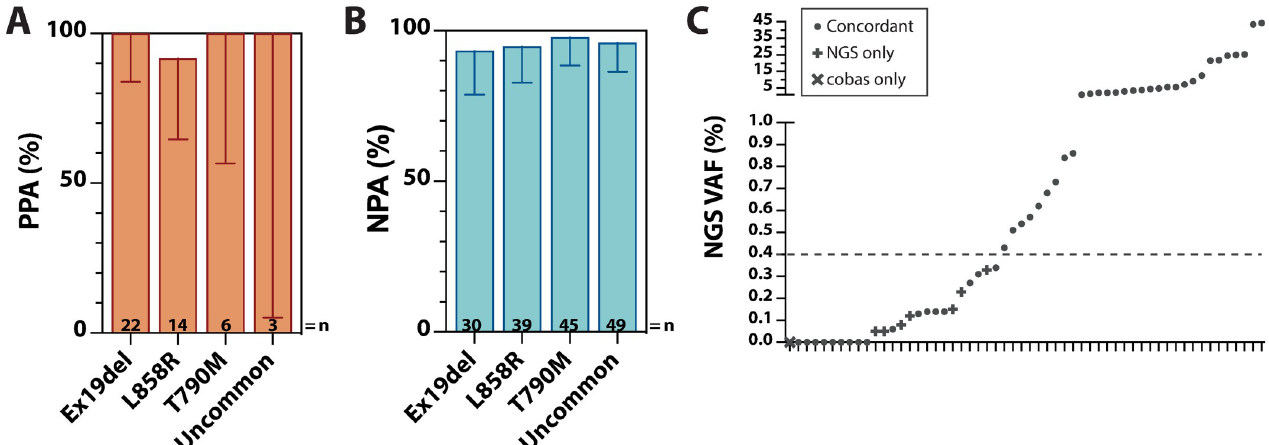
Fig 4. Clinical validation for detection of EGFR alterations. (A ) Positive percent agreement (PPA), and ( B ) negative percent agreement (NPA) of LiquidHALLMARK EGFR variant calls relative to cobas EGFR Mutation Test v2 in 50 clinical lung cancer samples. Uncommon EGFR variants include G719X, S768I, and exon 20 insertions. Error bars in A and B represent 95% CI. ( C ) Positive and negative concordance of LiquidHALLMARK EGFR variant calls relative to cobas EGFR Mutation Test v2. VAF, variant allele frequency. Each data point represents a negative sample (VAF = 0%) or EGFR variant; •, concordant call between LiquidHALLMARK and cobas; x, detected only by cobas; +, detected only by LiquidHALLMARK (NGS). Above 0.4% VAF, both assays were concordant for all detected EGFR